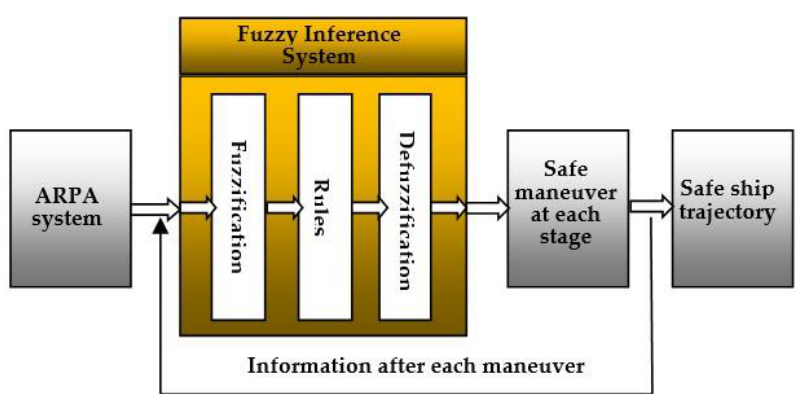
Figure 1. The flowchart of the proposed decision-support system principle .